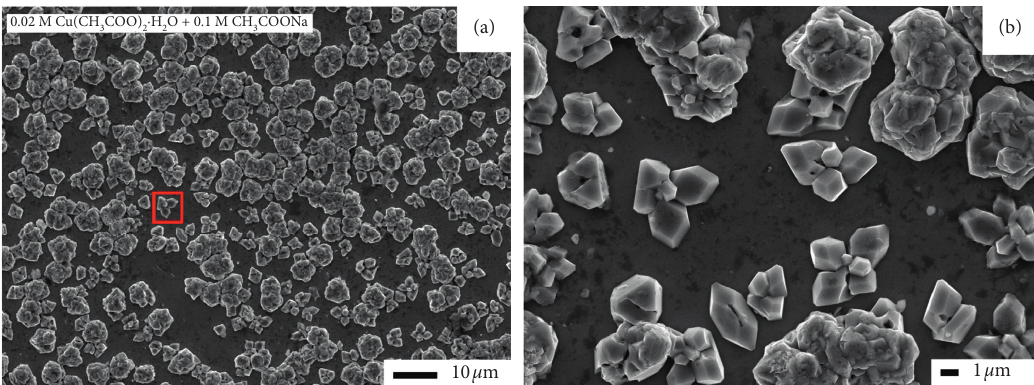
Figure 9: SEM images of electrodeposition of the CuO-Cu